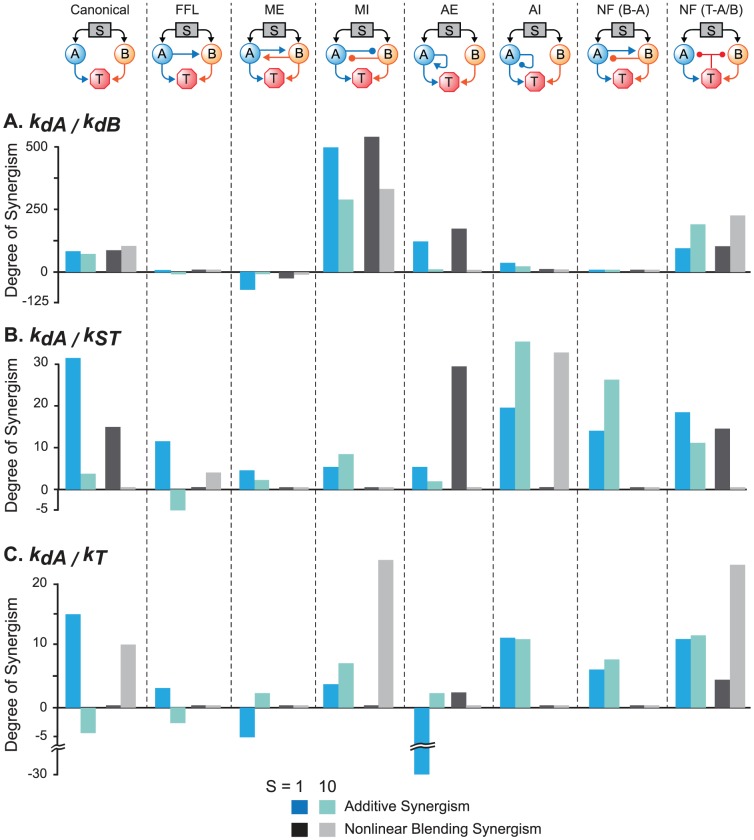
Summary of the degrees of NB and additive synergism observed for all motifs for S = 1 and S = 10.Degrees of synergism are plotted for kdA/kdB (A), kdA/kST (B), and kdA/KT (C). Motif abbreviations are as in Fig. 1. Vertical dashed lines delineate each motif and its associated synergism degrees (four for each combination of a motif and a parameter pair). For each motif and parameter pair, the degrees of additive synergism are plotted as blue and light green bars, and the degrees of additive synergism are plotted as black and grey bars, for S = 1 and S = 10 respectively. Negative values represent degrees of antagonism. In a few cases, the NB and AE curves were intertwined (e.g., Fig. S1B1) and exhibited both additive synergism and additive antagonism. For those cases only positive values (synergism) are plotted. The values of some data are too small to be easily visualized.